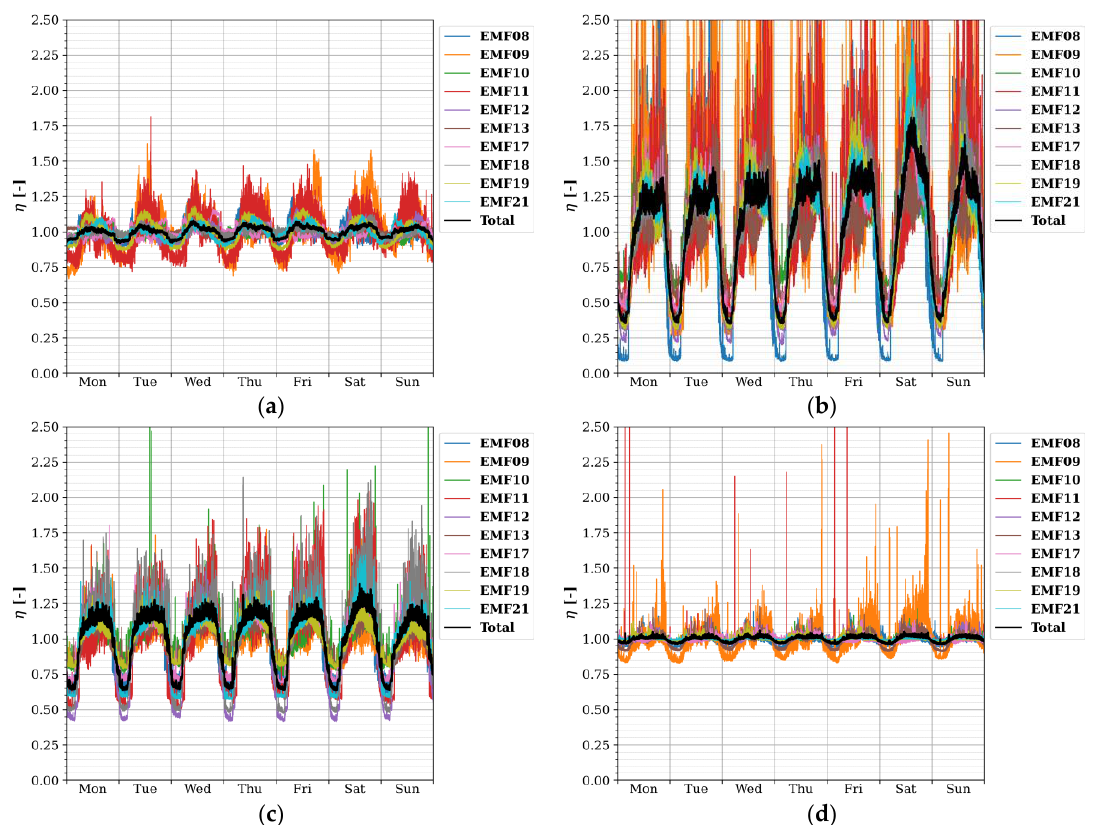
Figure 8. Weekly temporal profiles TP W with resolution Δ t of 30 s for each fixed RF sensor (and the area total) and for different frequencies ( a ) 900 MHz; ( b ) 1800 MHz; ( c ) 2100 MHz; and ( d ) 2400 MHz. Here, η is the average power density at a certain time of the week normalized to the weekly average. Some data for 1800 and 2400 MHz were censored to allow for visual comparison of the different frequencies ( η values reached up to 5 for 1800 MHz).